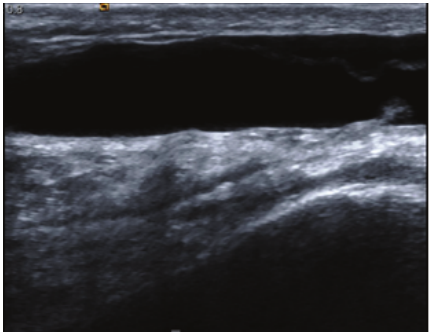
Figure 2: Ultrasound appearance of fluid collection lying anterior to extensor mechanism of right